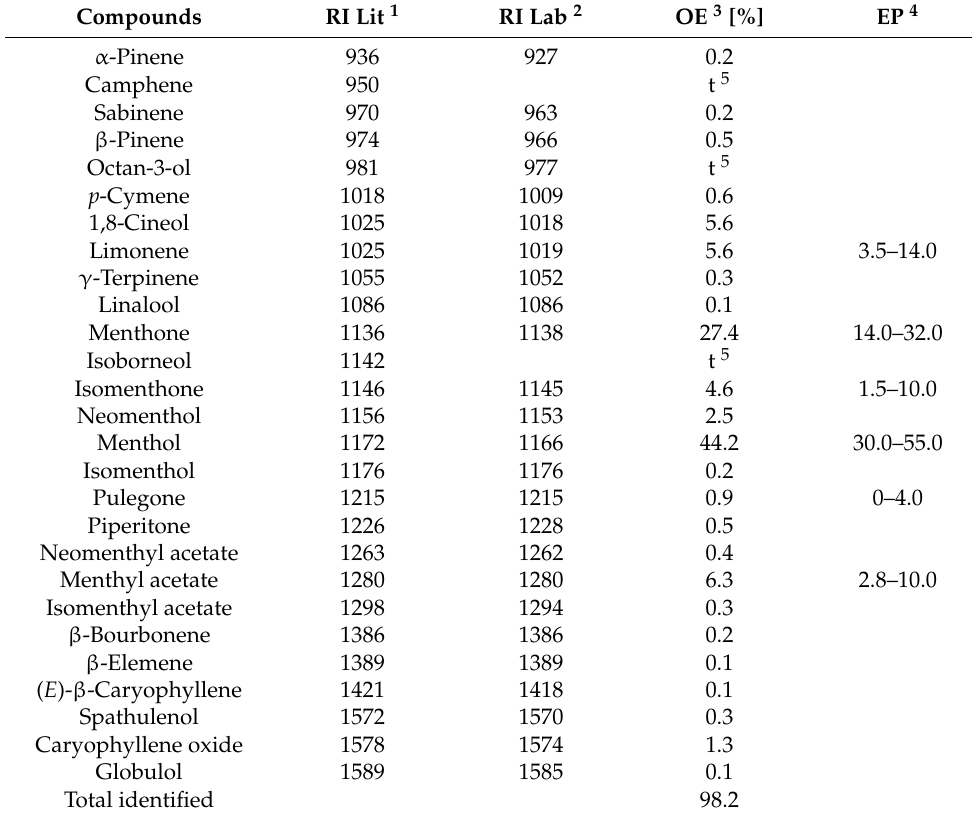
Table 1. The composition of peppermint essential